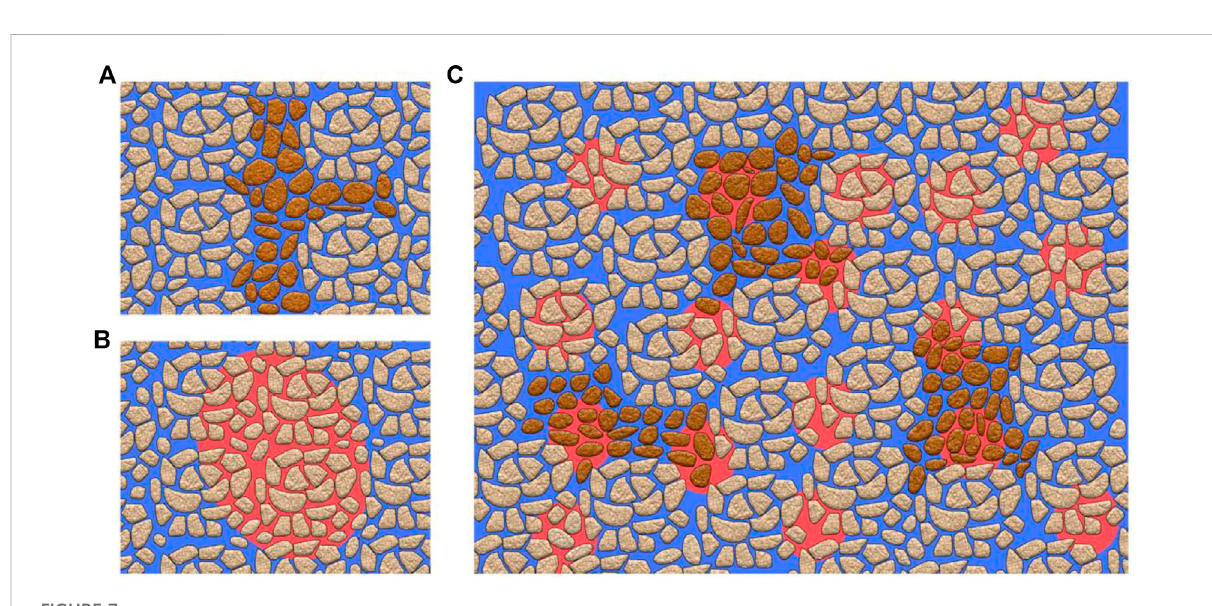
FIGURE 7 Double-porositysolidstructuresaturatedwithasingle fl uid (A) ,patchysaturationwithtwoimmiscible fl uidphaseswithinasingle-porositysolid (B) and combination of the two types of heterogeneity (C) . The blue and red zones represent the two immiscible fl uids.